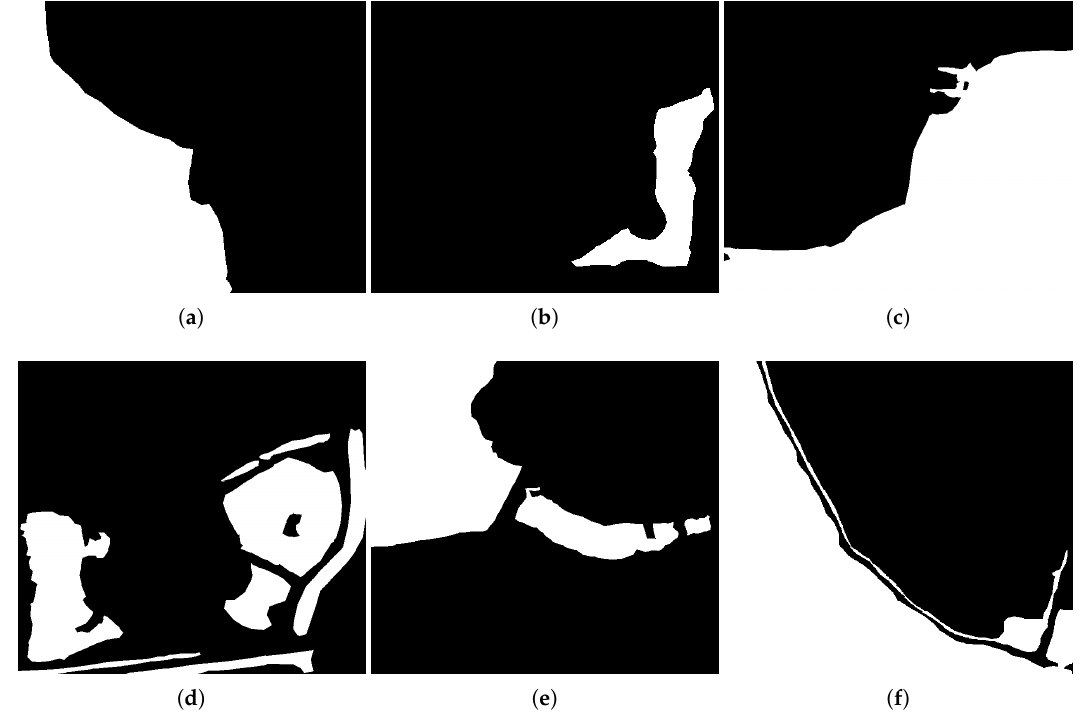
Figure 7. The ground truth data of GF-3 images by visual interpretation.